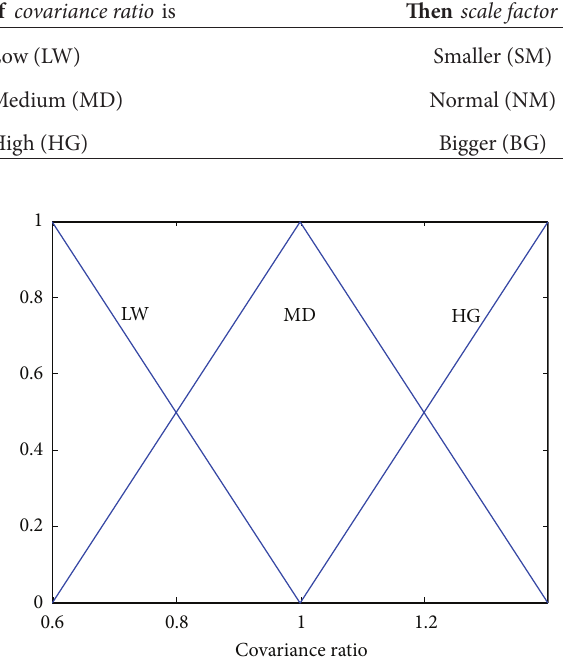
Figure 3: Fuzzification for covariance ratio.